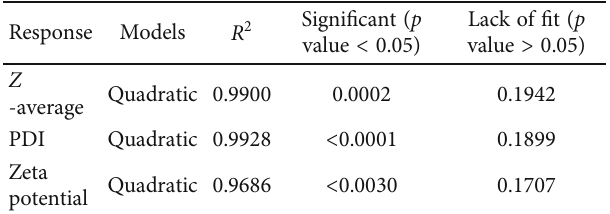
Table 2: Fitting the